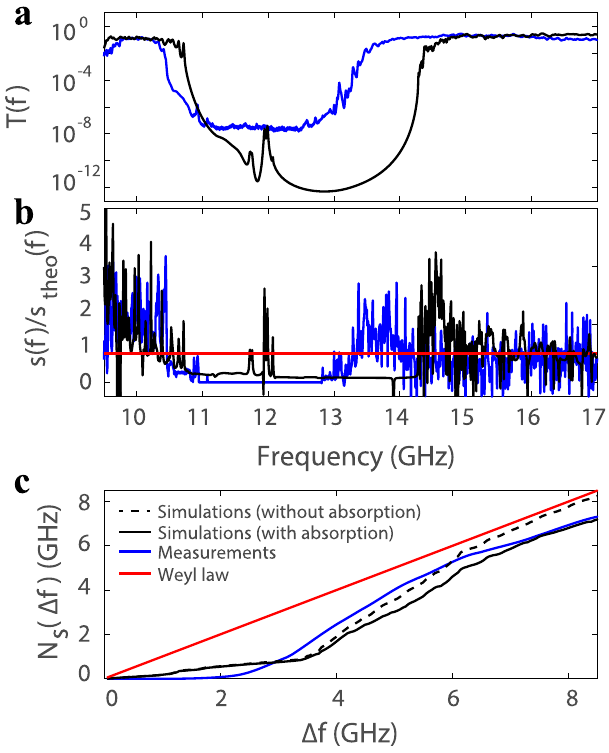
Fig. 4 Path lengths in a photonic crystal. a , b Frequency spectra ( a ) of the transmission and ( b ) of the mean path length in a photonic crystal obtained in measurements to which the free space contribution has been removed outside the band gap (blue line) and in simulations with absorption (black line). A transmission band gap is clearly observed for this sample with 15 longitudinal layers of regularly spaced scatterers. c Integral of the mean path length normalized by its theoretical value over a frequency window spanning Δ f around the center of the band gap. The black dashed line is the result of simulations in absence of absorption. The decrease of the mean path length within the band gap is followed by a strong enhancement starting at the band edges such that the frequency-averaged value progressively converges towards the theoretical Weyl prediction. The experimental data (blue solid line) shows the same trend, but stays slightly below the Weyl prediction for large Δ f due to absorption (see agreement with the simulations including absorption, black solid